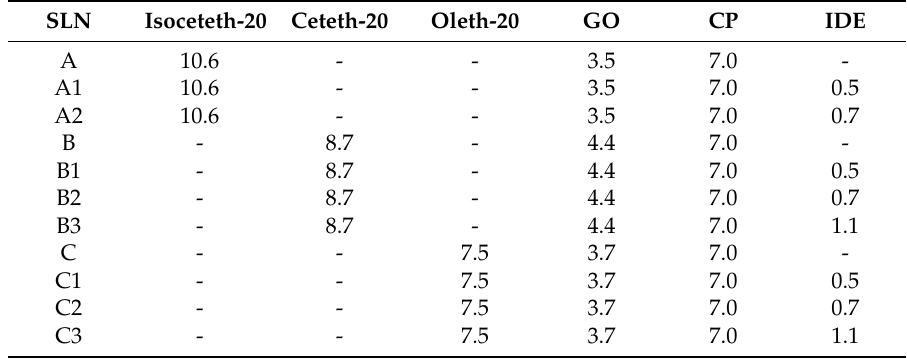
Table 5. Composition of the oil phase of unloaded and IDE-loaded SLN. Values are expressed as % w/w with respect to the total amount of SLN